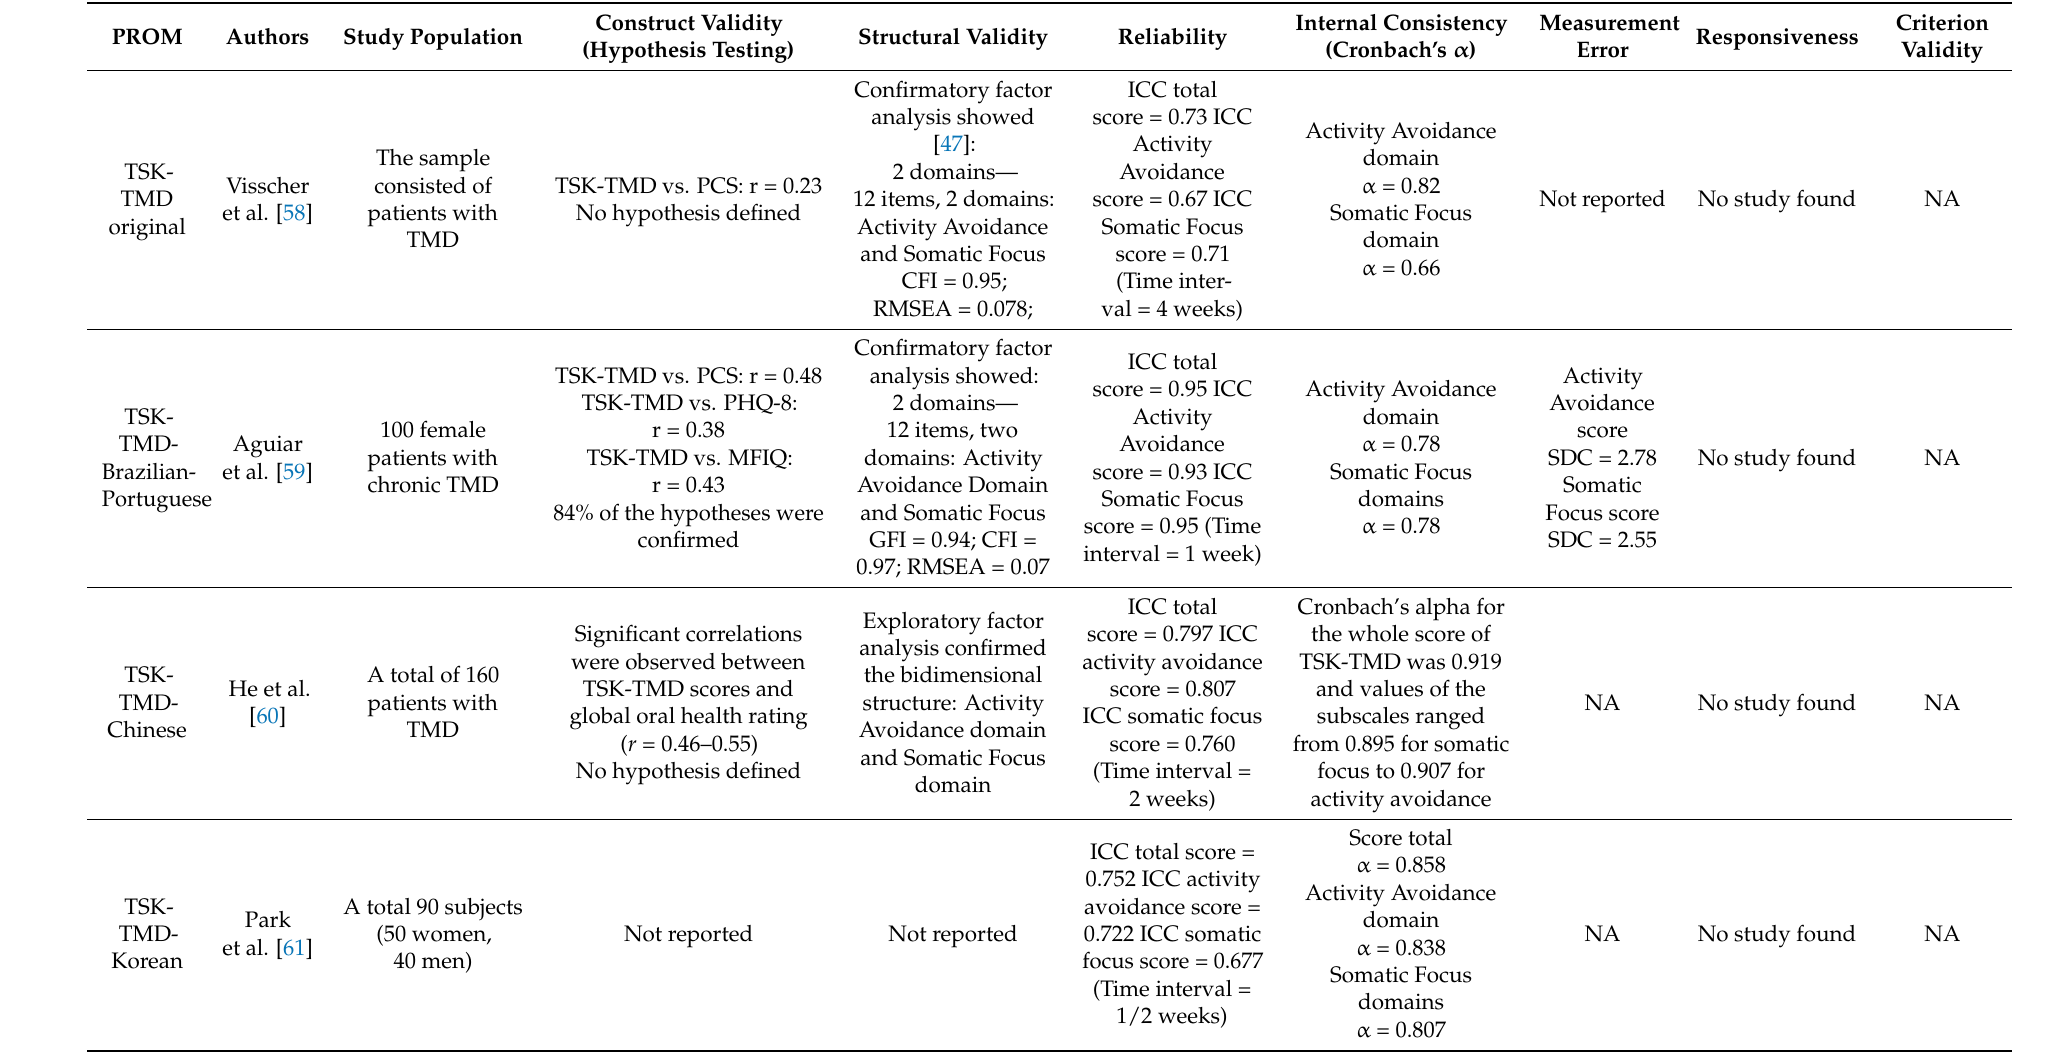
Table 11. Summary of the measurement properties of Tampa Scale for Kinesiophobia for Temporomandibular Disorders (TSK-TMD)